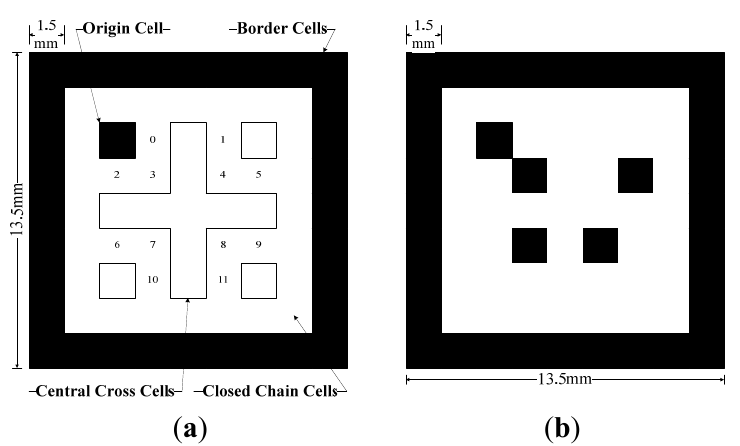
Figure 2. Fiducial Marker Structure ( a ) and a marker ID sample ( b